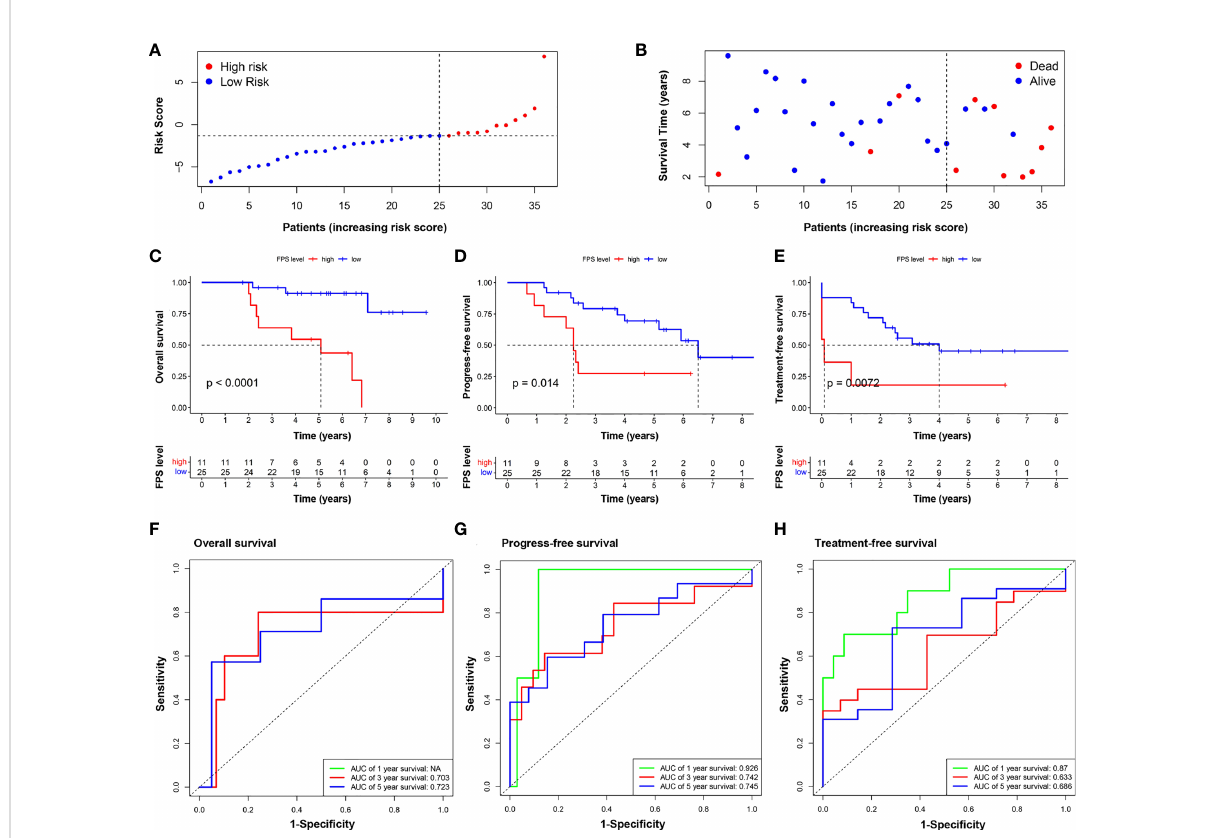
FIGURE 5 Validation of the nine-FRG signature prognostic model. (A) The distribution and the value of risk scores in the validation cohort. (B) The distributions of OS status, OS, and risk score. Kaplan – Meier survival curves for OS (C) , PFS (D) , and TFS (E) of CLL patients strati fi ed by FPS risk score. Time-dependent ROC curves of the risk model for predicting the 1-, 3-, and 5-year OS (F) , PFS (G) , and TFS (H)